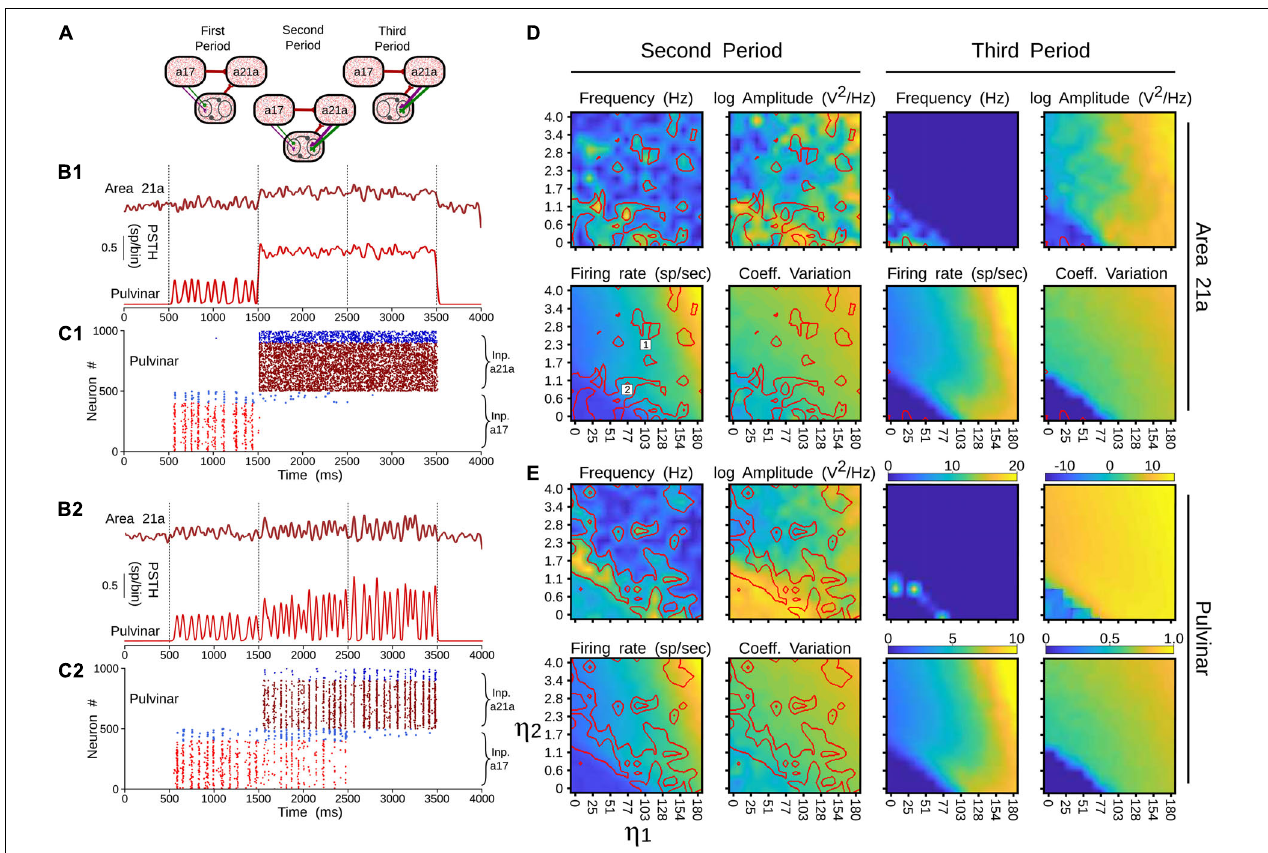
FIGURE 12 | Effects on alpha waves when the loop between area 21a and the pulvinar is closed in the cortico-thalamo-cortical model. (A) Scheme showing the temporal configuration of the three periods for the connections of the model. Panels (B,C) are two solutions when top-down loop to the pulvinar generate asynchronous (1) or oscillatory (2) responses. (B) PSTH for area 21a and pulvinar. (C) Raster plots for pulvinar neurons with striate- and extrastriate-recipient zones. Second and third periods’ quantitative outputs (frequencies, amplitudes, firing rates and CVs) for area 21a (D) and (E) pulvinar networks when η 21 a 1 and η 21 a 2 are increased gradually. Note the position of solutions 1 and 2 in the panel (D) .